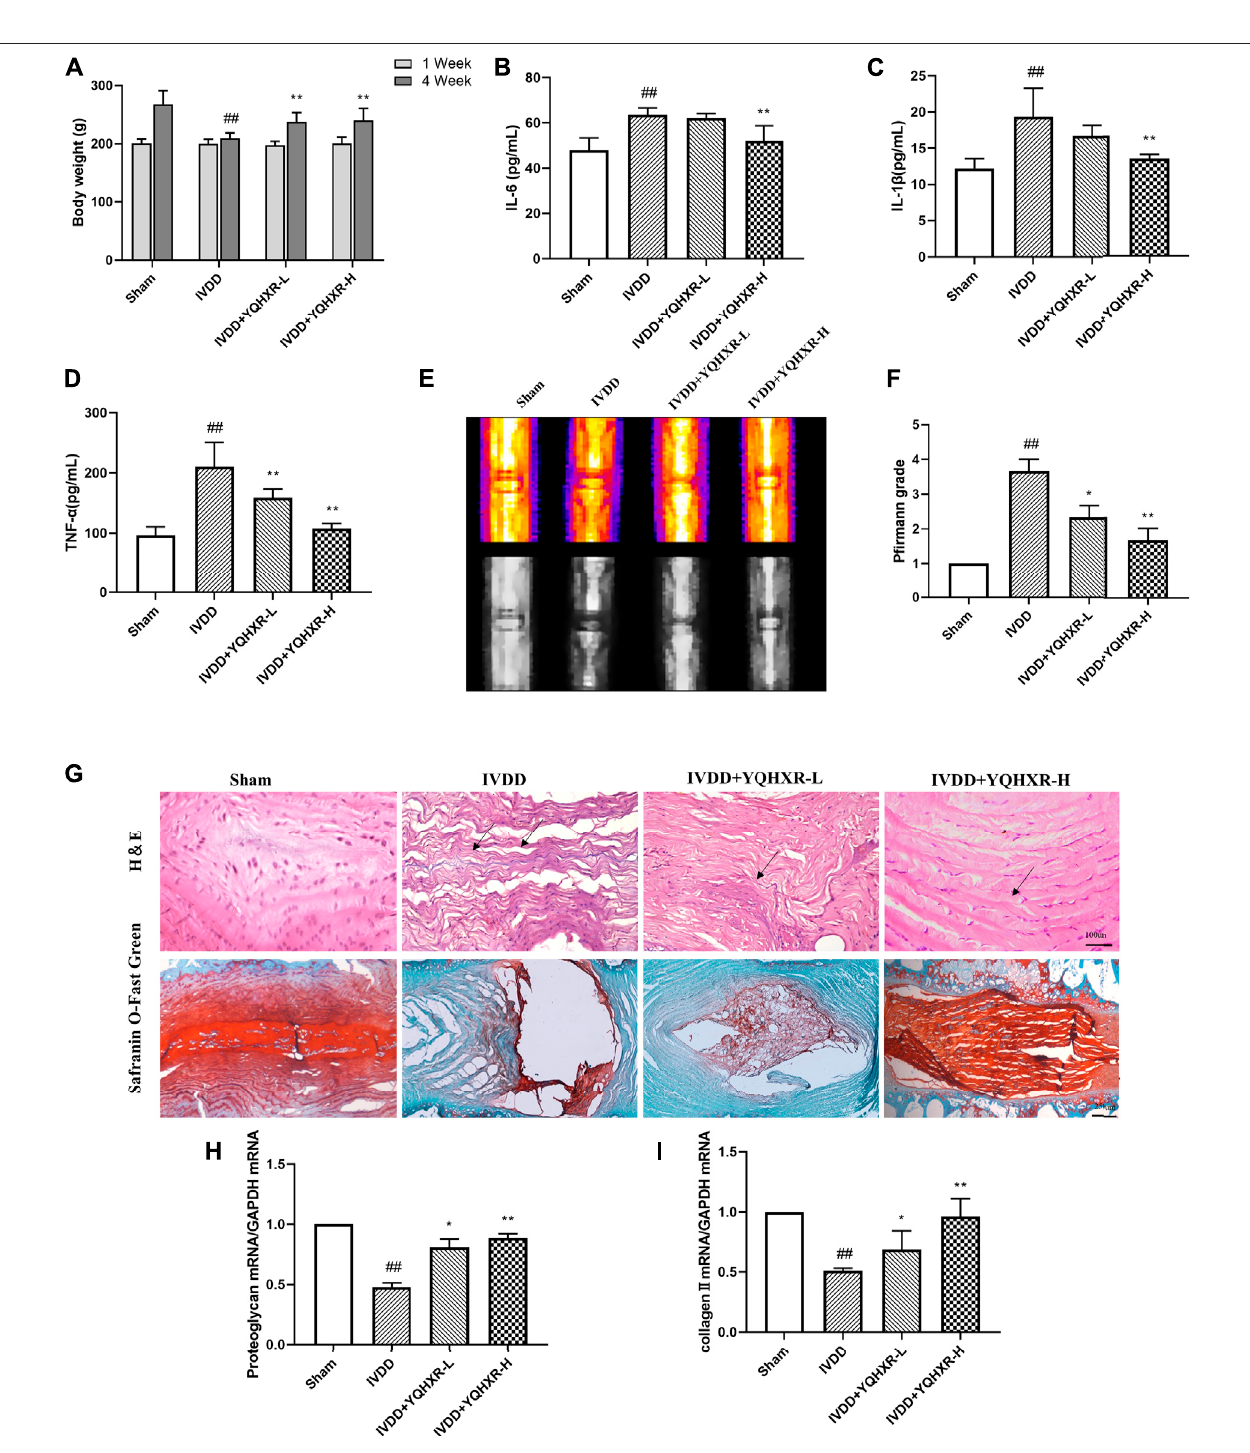
FIGURE2| YQBXRamelioratedIVDDprogressioninneedle-puncturedratmodel. (A) ThebodyweightofIVDDrats. (B – D) Levelsofin fl ammatoryfactorsinserum. (E) Representative images of IVDD rat tails on T2-weighted MRI at 4-weeks post-surgery. (F) P fi rrmann scores of MRI. (G) Representative images of the degenerative disc at 4-weeks post-surgery by H&E and Safranin O Fast Green staining. (H – I) Real-time assay was performed to evaluate the fi brosis of the degenerative disc in different groups. The data represent the mean ± SD. Signi fi cant differences are shown as ## p < 0.01 vs Sham group; * p < 0.05, ** p < 0.01 vs IVDD group.